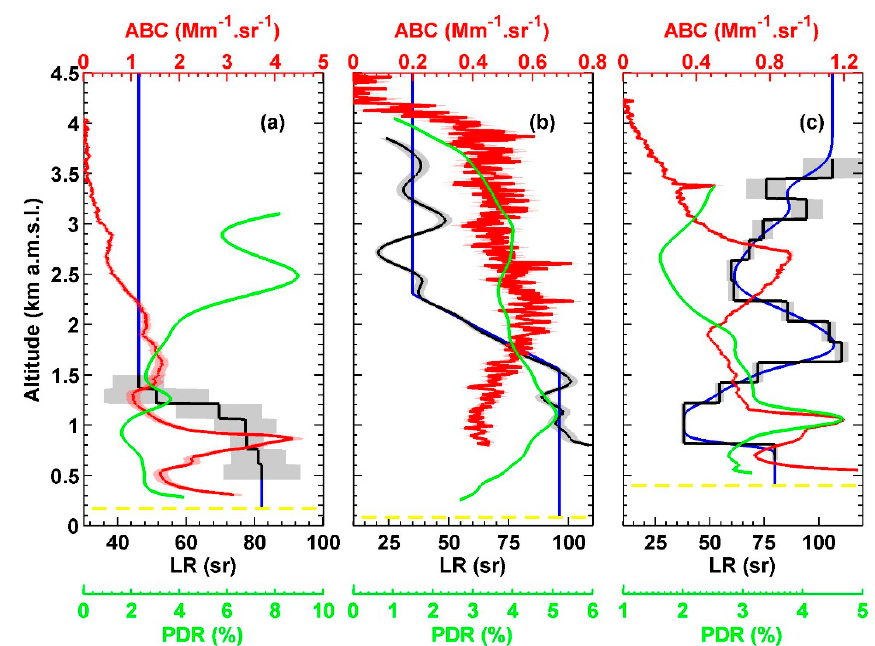
Figure 6. Average profiles of aerosol backscatter coefficient (ABC, in red), Lidar Ratio (LR, in black) and linear Particle Depolarization Ratio (PDR, in green) above three Russian cities. ( a ) Moscow: Early morning 90-min average profile (06:15–07:45 LT or 02:15–03:45 UTC) using the multi-layer Raman constrained Klett inversion method. ( b ) Ufa: 3.3-h average profile (00:40–04:00 LT or 19:40–23:00 UTC) using the standard Raman inversion method with a Gaussian-derivative filter. ( c ) Irkutsk: 4-h time average (23:10–03:15 LT or 15:10–19:15 UTC) using the multi-layer Raman constrained Klett inversion method. The shaded areas correspond to the 1- σ standard deviation; the yellow lines indicate ground level and the blue lines show the completed/smoothed LR profiles used to invert the 5-min average profiles of Figures 7–9 (respectively).